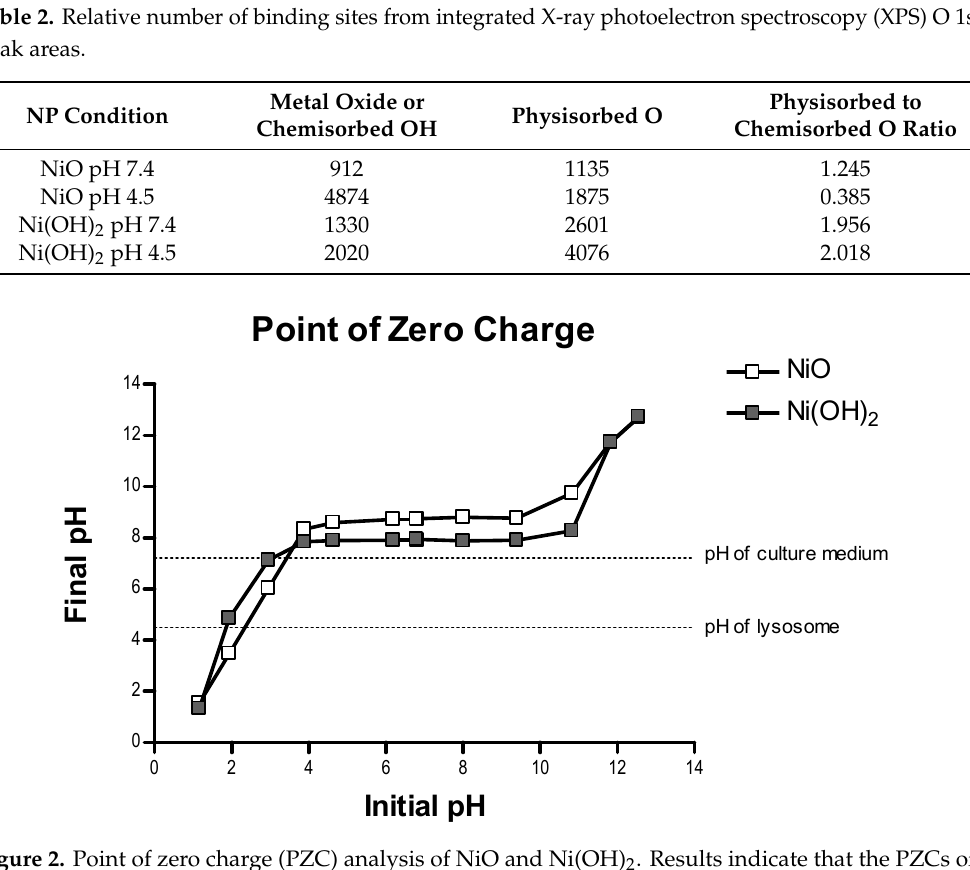
Table 1. Physical characteristics of NiO and Ni(OH) 2 NPs. Data are expressed as mean ± SD.